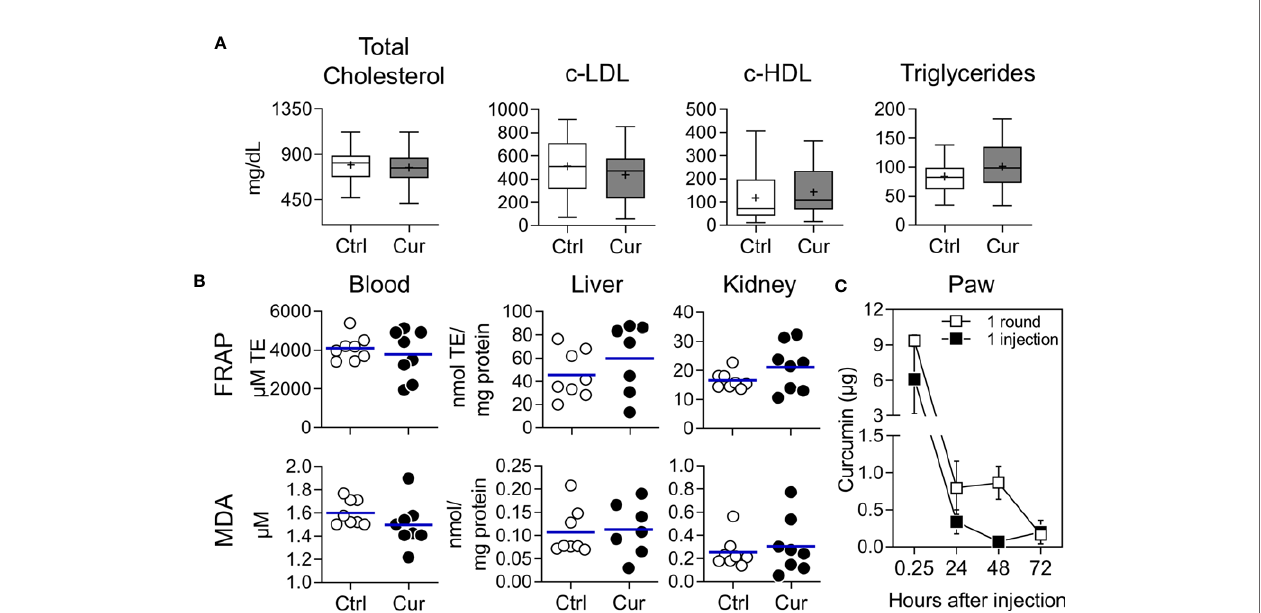
FIGURE 2 | Absence of systemic lipid-lowering or antioxidant effects in ApoE -/- mice treated with subcutaneous microdose curcumin. (A, B) Dyslipidemic ApoE -/- mice were treated with curcumin (Cur) or vehicle (Ctrl) as shown in Figure 1A . (A) Total cholesterol, c-LDL, c-HDL, and triglycerides were measured in serum samples at the end of the experiment. (B) The antioxidant effect of curcumin in vivo was assessed by preparing blood, liver and kidney homogenates and evaluating the antioxidant capacity with the FRAP method (upper panel) or quantifying the concentration of the lipid peroxidation products MDA (lower panel) for each matrix. Results presented in (A) correspond to two pooled experiments (n=27 mice/group) and plotted as box and whiskers. Results in (B) correspond to one experiment (n=7-8 mice/group) and each dot represents an individual animal and the line the mean for each group. (A, B) Mann-Whitney U test was performed resulting in the two treatment groups not being statistically different at any measurement. (C) For the biodistribution experiment, groups of WT C57BL/6 mice were injected sc with curcumin (10 µg) in the hind footpad, euthanized ¼, 24, 48 and 72 h after one injection or one round of treatment (see Figure 1A ), and the amount of curcumin recovered from the whole paw, dLN and serum homogenates was determined by fl uorescence spectrometry (see Materials and Methods for details). Mice injected with vehicle were used as blanks. Results are presented as mean ± SEM for each timepoint (n=3). Curcumin amounts in dLN and serum samples were below the limit of quanti fi cation of the technique (0.1 µg; data not